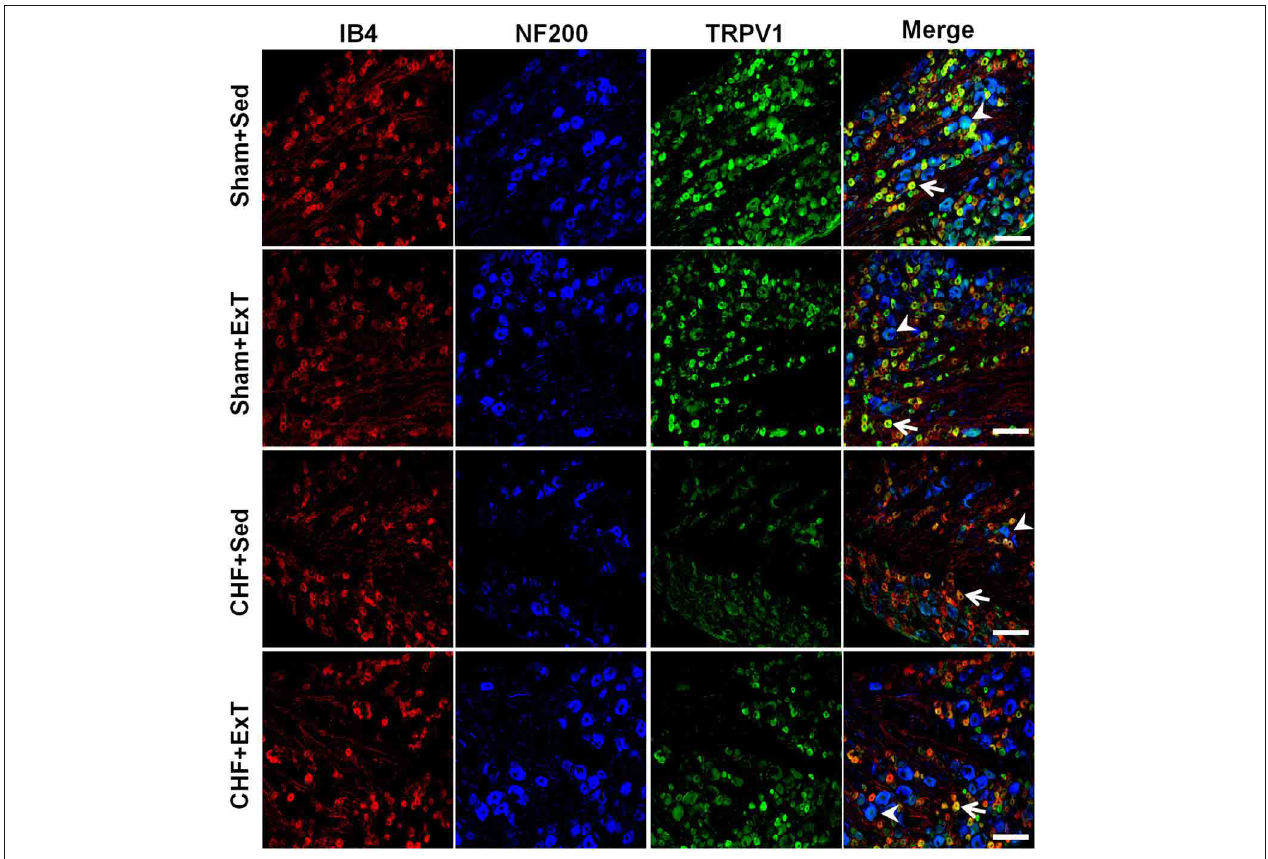
FIGURE 11 | Immunohistochemical data showing the protein expression of TRPV1 receptors in L4/L5 dorsal root ganglion (DRG) in sham and CHF rats. IB4, a C-fiber neuron marker; NF200, an A-fiber neuron marker. White Bar = 100 μ m. White